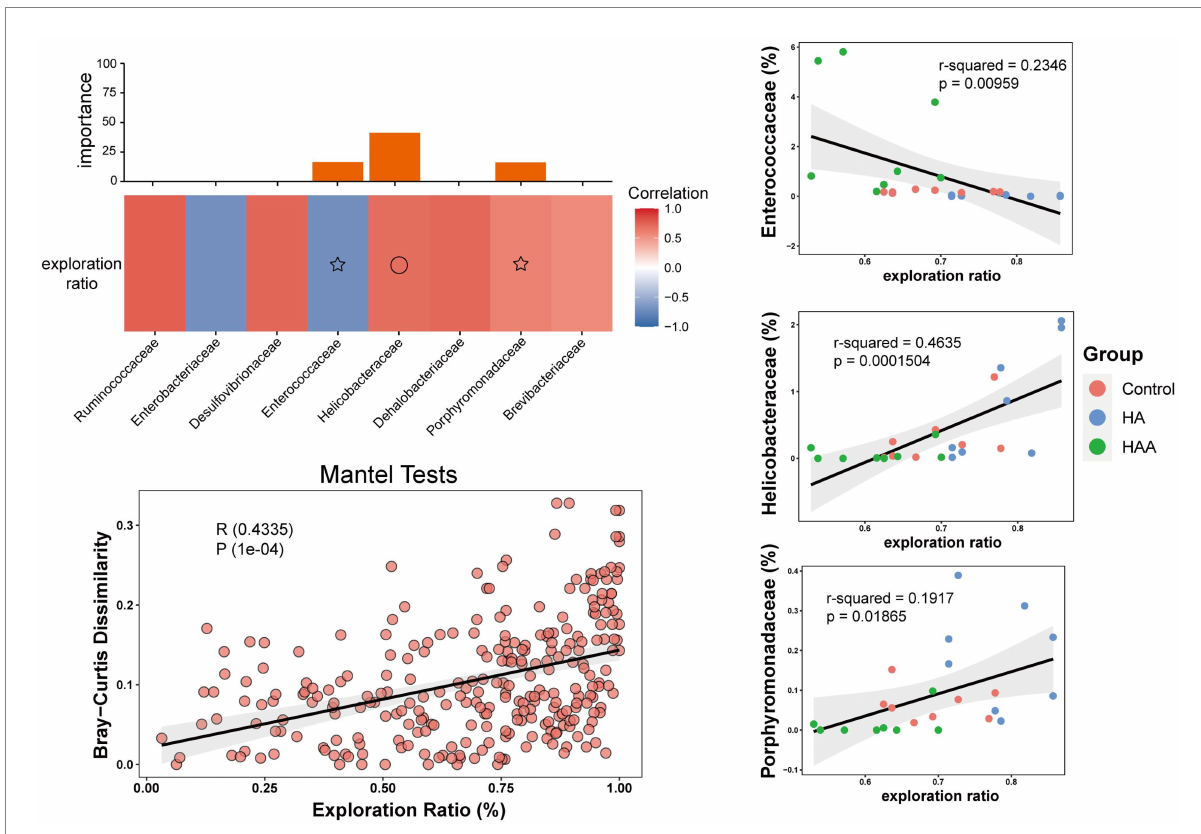
FIGURE 9 Correlation between microbial community and behavioral test in the colon. (A) Different colors represent positive (red) or negative (blue) correlation of important family-level microbes with behavioral results. Circles and asterisks represent different levels of importance. (B–D) The different results represent the importance of having three species at the family level in behavioral performance. Red circle: control group. Blue circle: HAE group. Green circle: HAE-A group. (E) Mantel Test is a correlation test to determine the correlation between two sets of distance measure matrices. And it is used to evaluate whether the sample distance in one matrix is related to the sample distance in the other